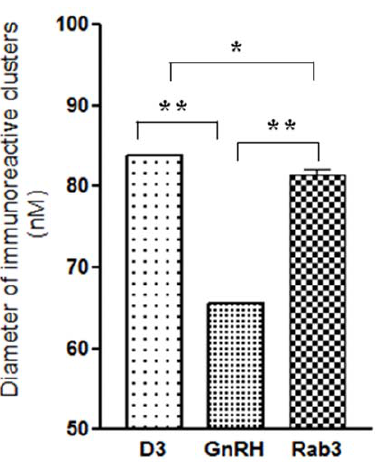
Figure 3. Diameter of immunoreactive clusters in the outer zone of the rat hypothalamic median eminence stained for D3, GnRH or Rab3 detected by N-STORM superresolution micros- copy. **P , 0.001; *P , 0.05 by ANOVA followed by Newman-Keuls post test. Data are shown as Mean 6 SEM (N=500).